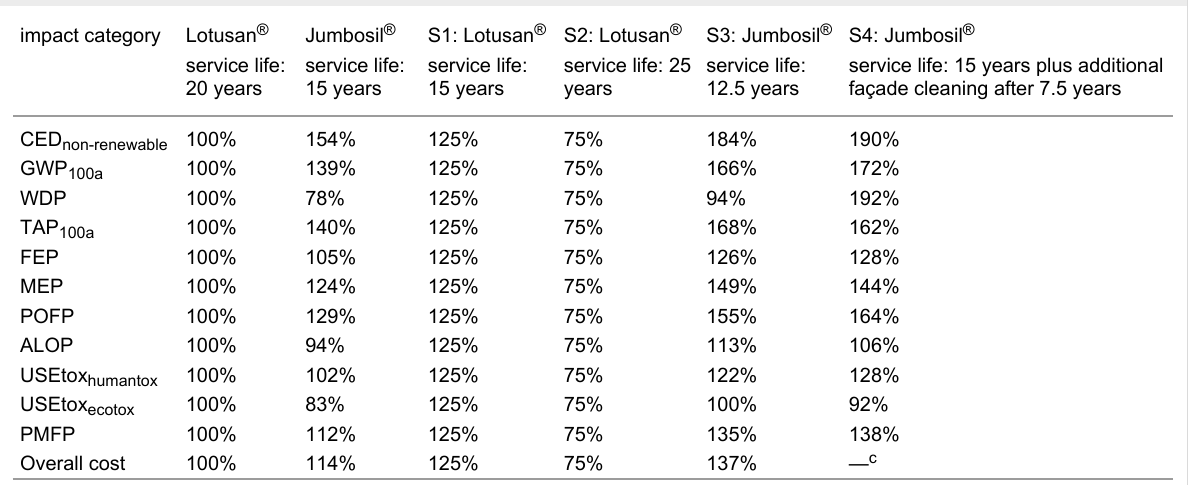
Table 3: Overall results of the scenario analyses a,b . impact category Lotusan